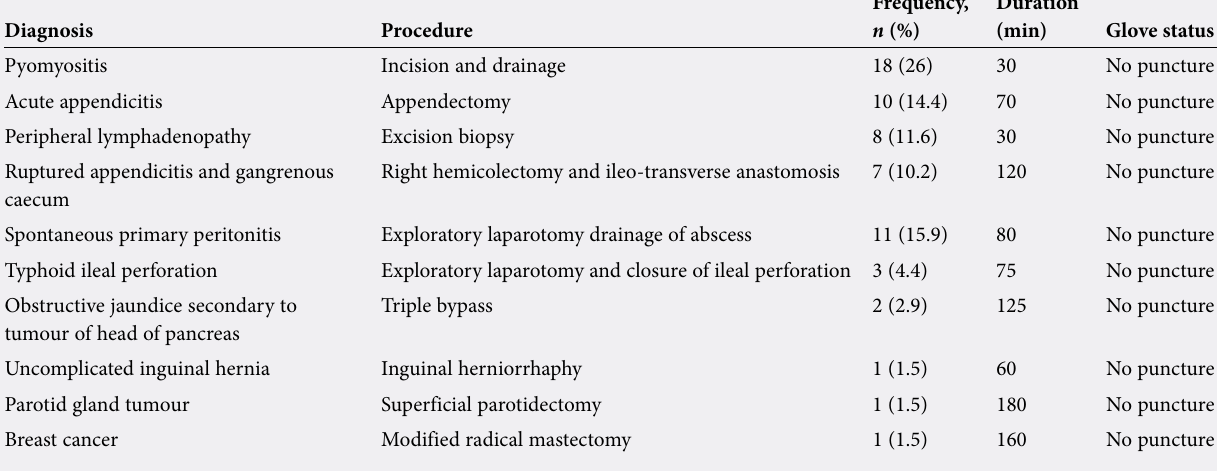
Table 2. Indications and surgical procedures performed on HIV/AIDS-positive patients